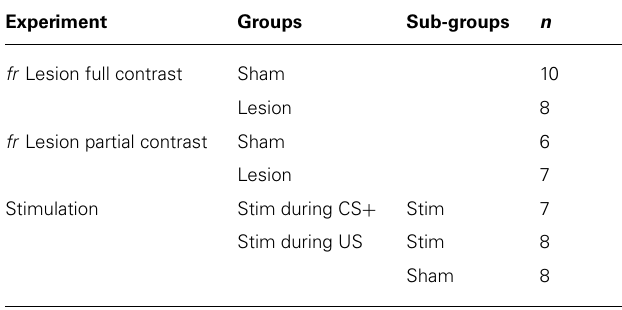
Table 1 | Experimental conditions for lesion and electrical stimulation